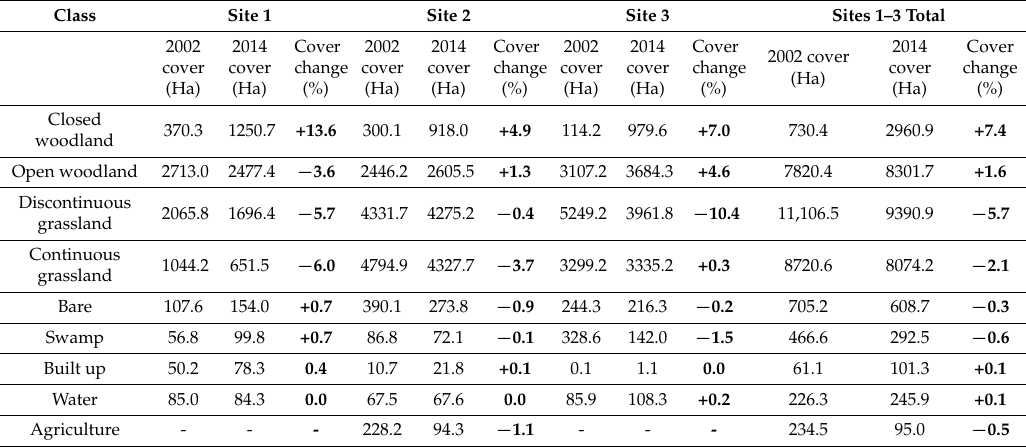
According to the VHR classifications the most common land cover class in February 2001 across all three sites was long grass (12,738.1 ha), followed by trees (4421.8 ha) and shrubs (4029.7 ha) (Table